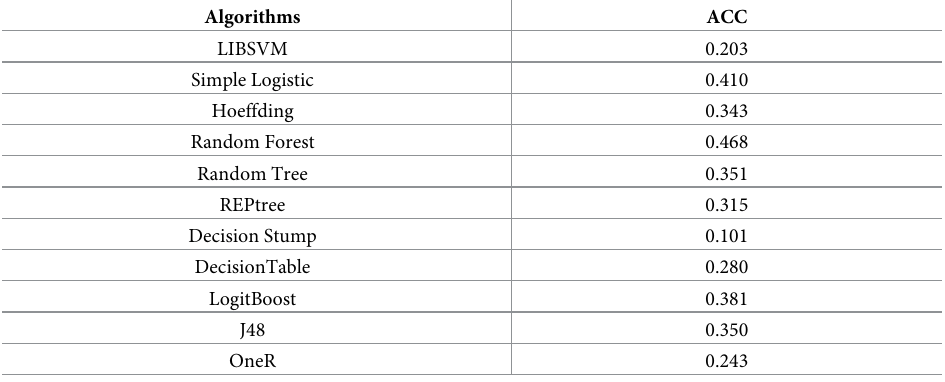
Table 2. The cross-validation results of each step 1 classifier compared with different learning algorithms.